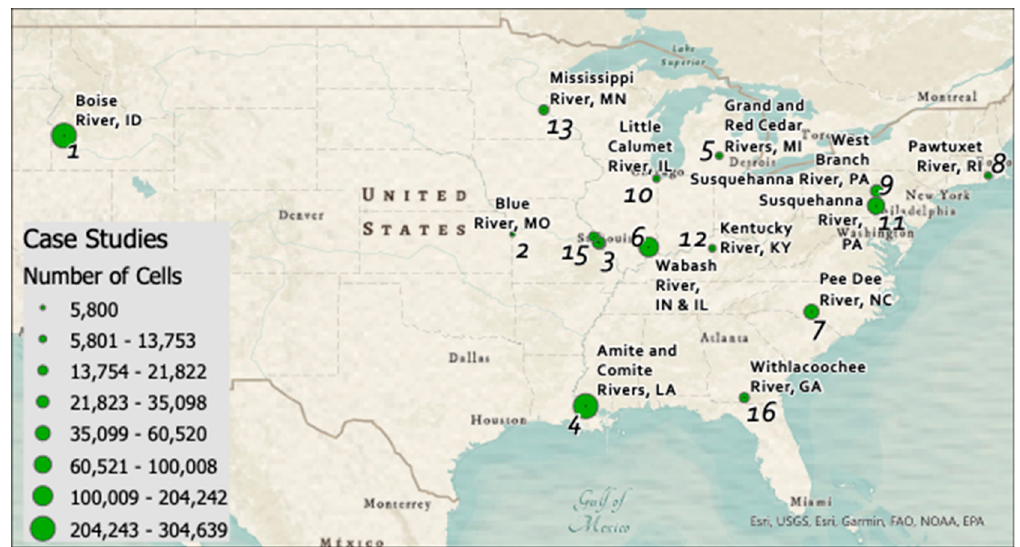
Figure 1. Distribution and size (number of grid cells) of the 16 USGS FIM case studies used for the optimization and evaluation analyses. Table 1. The 16 case studies used in the sensitivity analysis. The number of cells is for the 10 m NED DEM. Mean and max depth are from the USGS FIM floodwater depth rasters (HEC-RAS simulated).